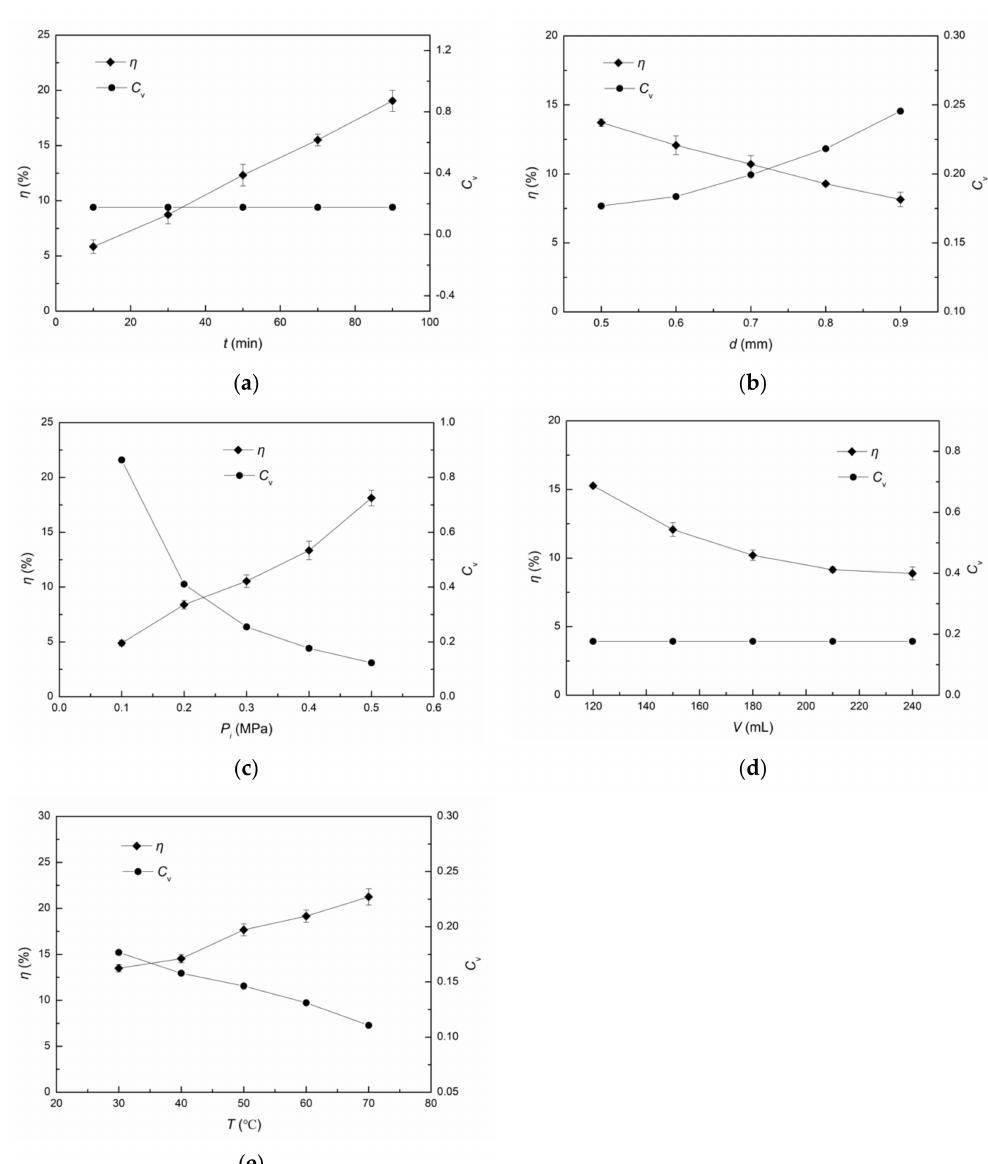
Figure 11. Influence of various factors on the intrinsic viscosity reduction rate of CS. Influence factors: